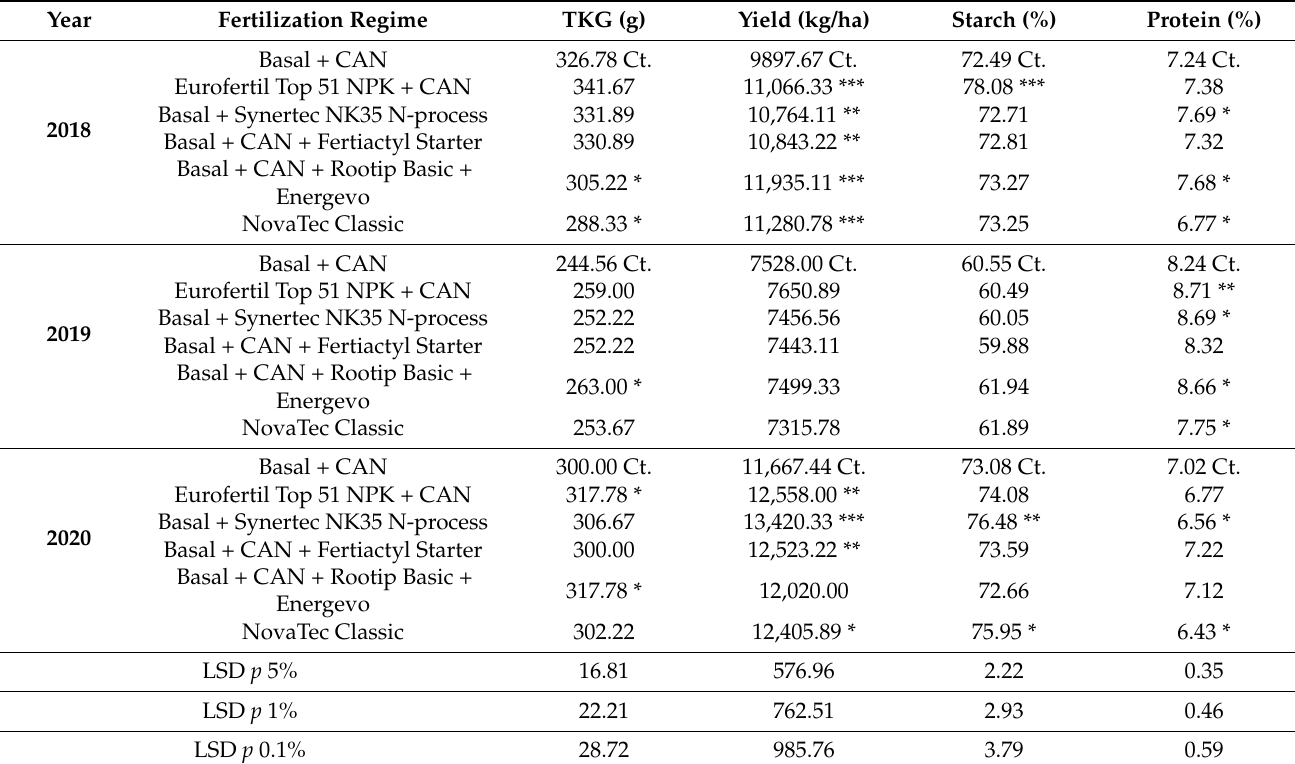
Table 3. Influence of the interaction year × fertilization regime on productivity traits of maize